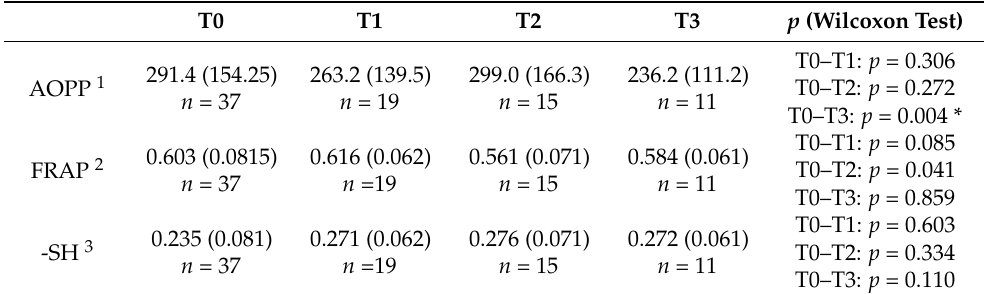
Table 2. Biochemical analysis of redox properties of patients’ plasma at different time points. Values are expressed as median (IQR) and the number of patients ( n ).